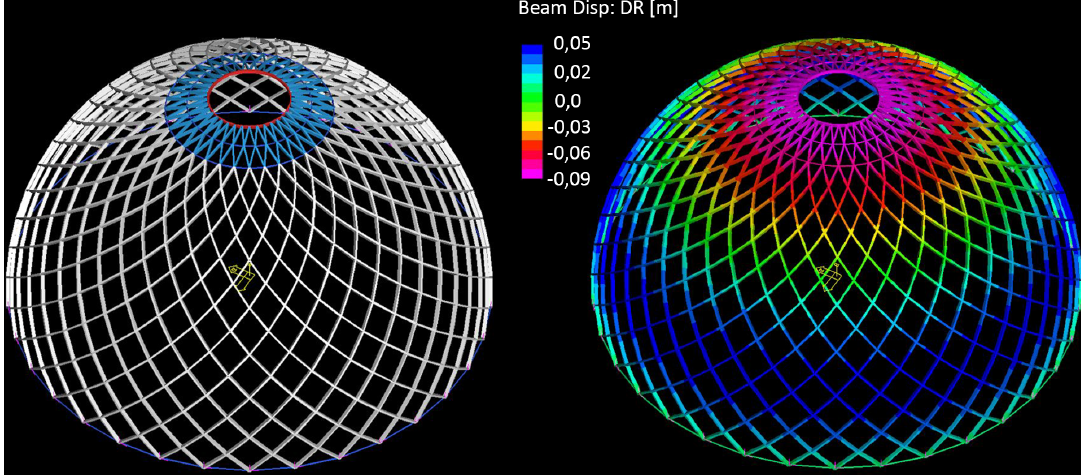
Figure 16: Left: Dome with reciprocal frame beam elements. Right: displacements in radial direction